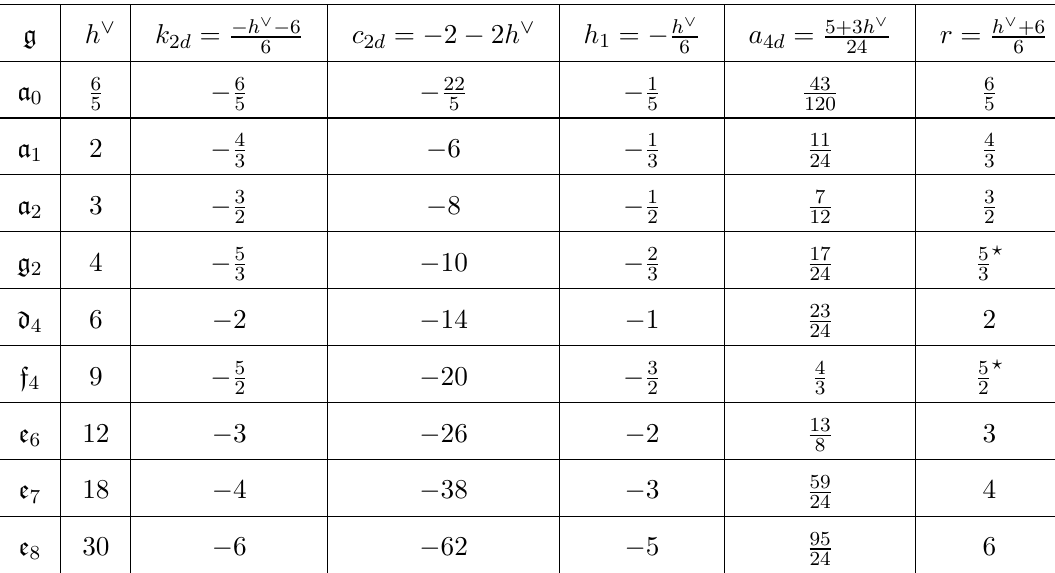
Table 3 . The Deligne-Cvitanovi´c series of simple Lie algebras, the data of the associated vertex algebras and the data of their (putative) parent 4 d SCFTs. The a 0 entry is formally a member of the list corresponding to the trivial Lie algebra. It corresponds to the VOA of the (2 , 5) Virasoro minimal model. As the 4 d interpretation of the g 2 and f 4 cases is still unclear, the values of a 4 d and r for these entries are formal/conjectural. In particular even if these theories exist, the values of r may be different if the various assumptions we have made about their Coulomb branches do not